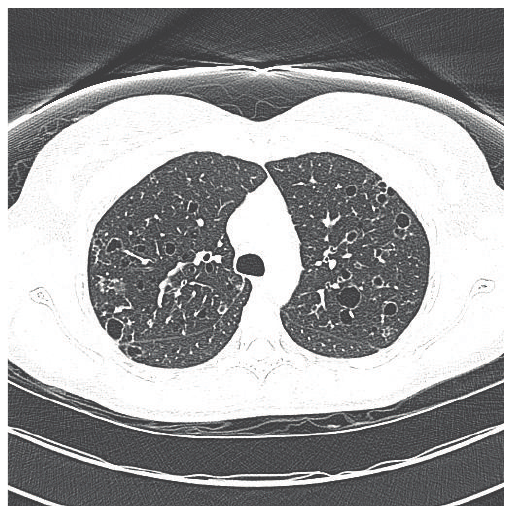
Figure 2: High-resolution chest CT.